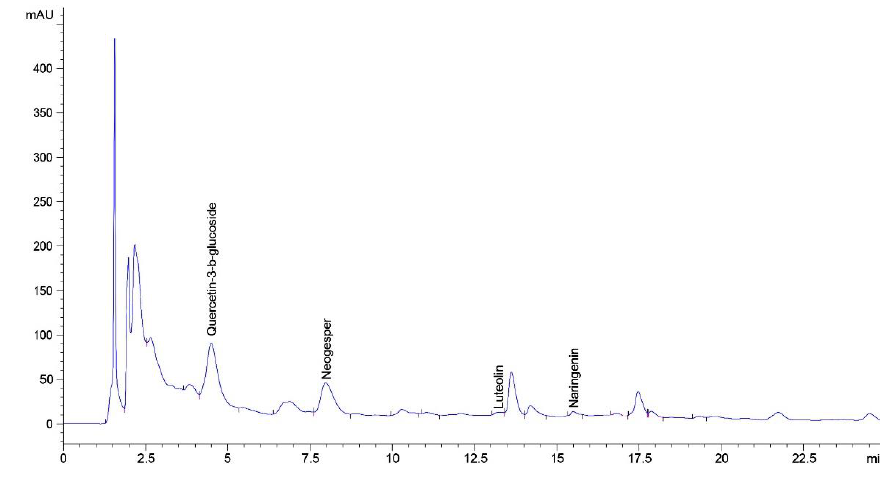
Figure 2. HPLC-chromatogram of the flavonoids of the herb extract of A. eupatoria . Neohesperidin, which belongs to the bitter glycosides of flavanones and provides a bitter taste of the raw material and a possible effect on the hepatobiliary system, prevails among the flavonoids in the herb extract of A. eupatoria [29]. This flavonoid has a sedative effect in combination with diosmin. Also, neohesperidin exhibits hypolipidemic and hypotensive activity [30]. Generally, flavonoids have a significant antioxidant, anti- inflammatory, anti-allergic potential. Kaempferol and its glycosides possess